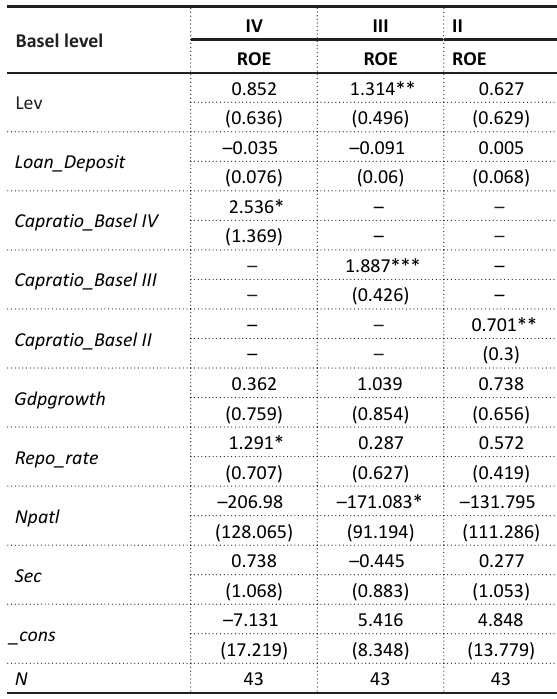
Table 5. Results of securitization and